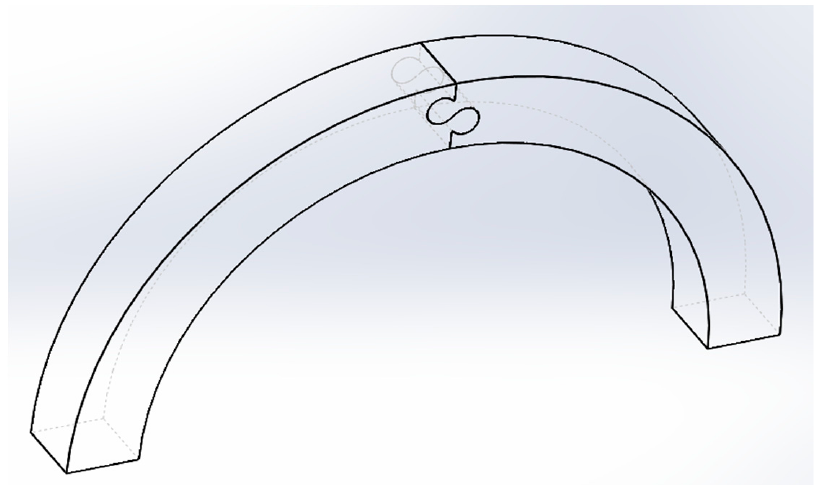
Figure 1. Representative archway pair with one full suture repeat.